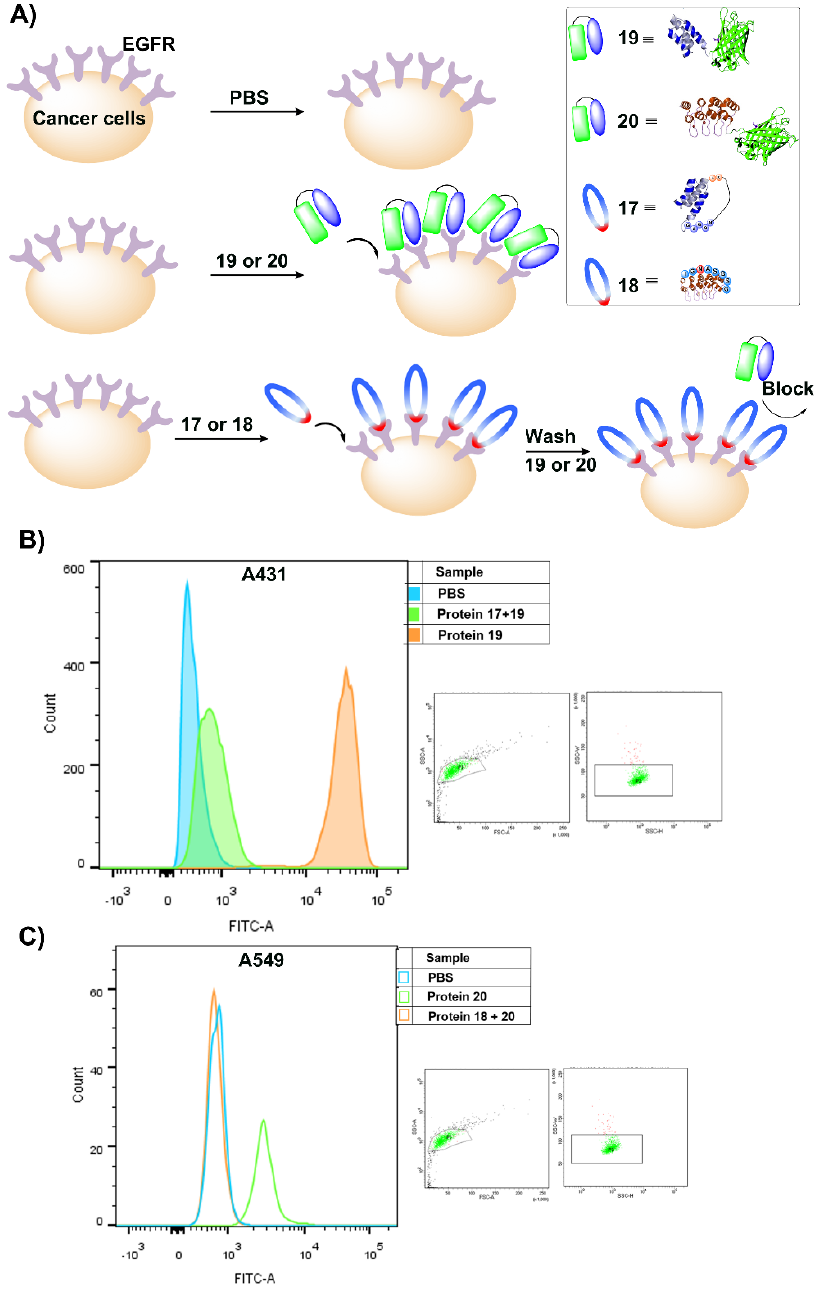
Figure 6. Receptor competitive binding assay to evaluate cyclic affibody Z EGFR 17 and DARPin 18 binding to the target receptors. ( A ) Schematic representation of the receptor competitive binding assay using the cyclic affibody as the example; ( B ) flow cytometry analysis of cyclic affibody 17 binding to the EGFR receptor; ( C ) flow cytometry analysis of cyclic DARPin 18 binding to EGFR receptor.